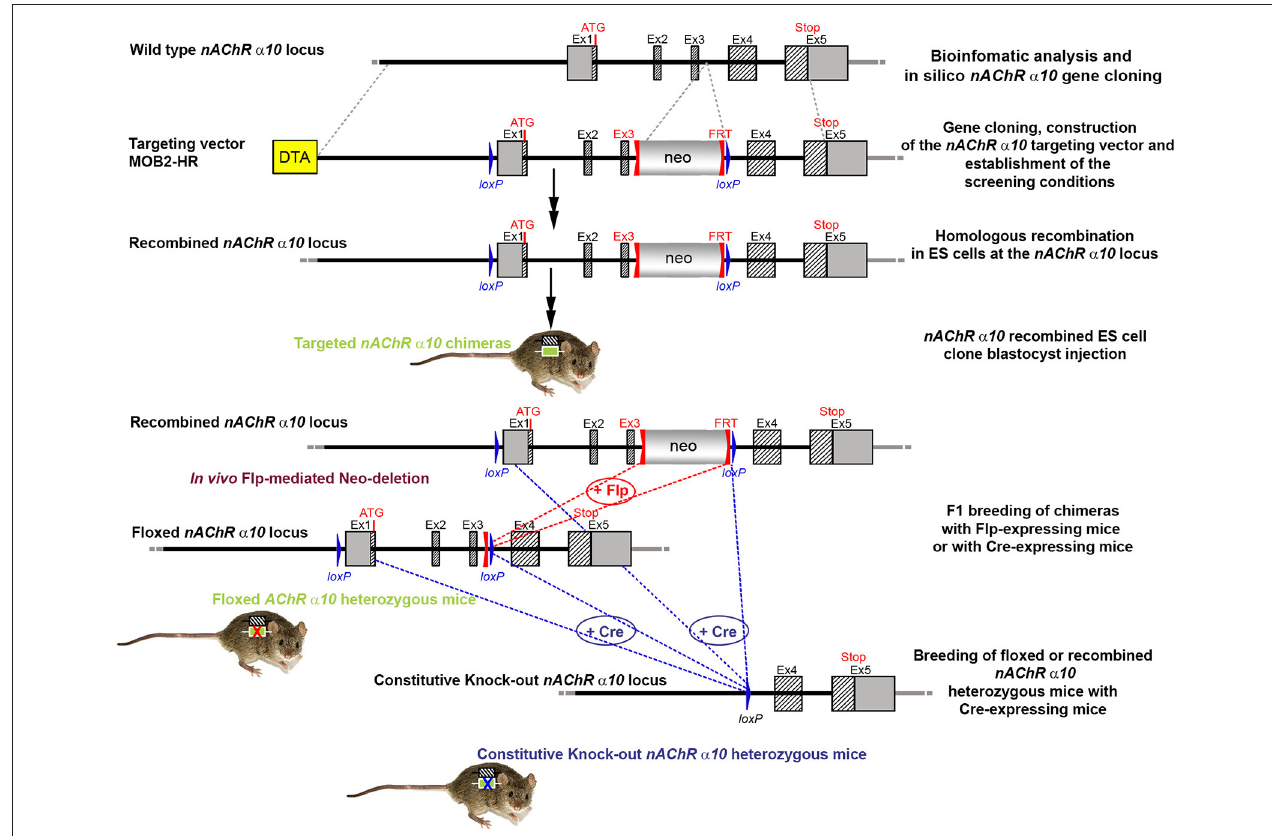
FIGURE 5 | The targeting strategy for the generation of the CHRNA10 knockout. Boxes represent exons. Solid line represents intronic sequences. LoxP and FRT elements are shown as blue and red triangles, respectively. Neo and DTA boxes represent the neomycin positive selection cassette and the Diphtheria Toxin A negative selection cassette. The constitutive KO was generated by breeding the floxed nAChR α 9 heterozygous mice with Cre-expressing